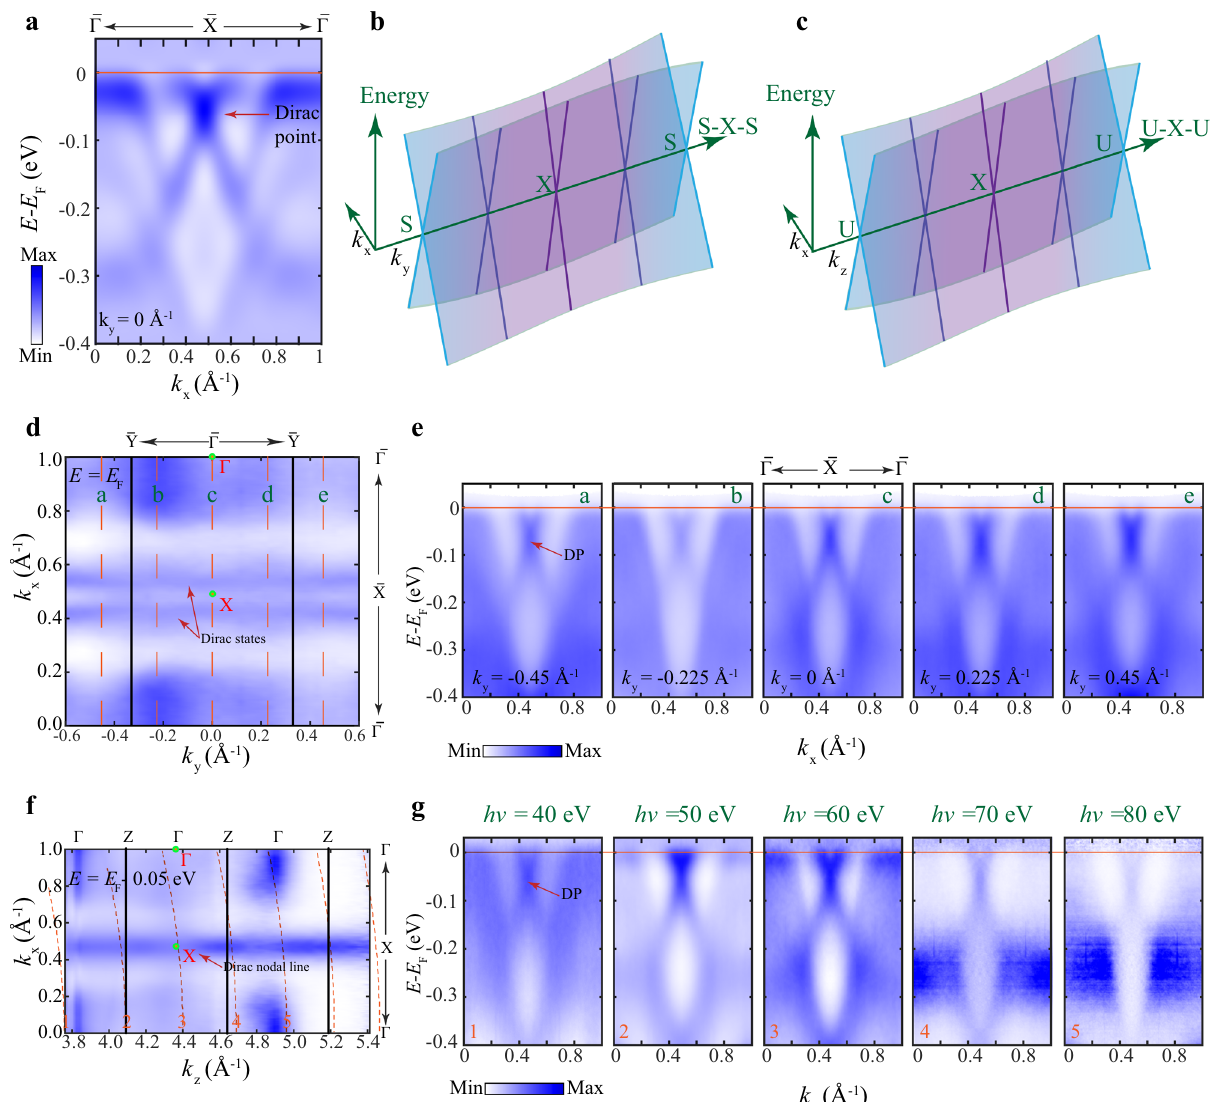
Fig. 2 Band structure of the 1D Dirac fermion of x = 0.43 ( n = 3) sample. a Second derivative of the photoemission spectrum d 2 A along d ω 2 Γ (cid:1) X (cid:1) Γ with DP labeled. b , c Schematic of the 1D Dirac fermion along the S-X-S ( k y ) and U-X-U ( k z ) directions. d The constant energy contour at Fermi energy ( E F ) in the k x – k y plane with Dirac surface sates labeled and theoretical BZ appended (black solid lines). e Sliced cut in Fig. 2d at different k y (orange dashed lines indicated in 2 d ) with DP labeled. f The energy contour near Fermi energy ( E F ) of the k x − k z plane with Dirac nodal line labeled. g Sliced cuts in Fig. 2f at different h ν ( k z - orange dashed lines) with DP labeled. To make a clear comparison, we symmetrized the dispersion according to the crystal symmetry. The data in Fig. 2a, d were collected at h ν = 55 Dirac cone dispersion along the k y direction could be found in Fig. 3e – j. As for x = 0.43 ( n = 3) sample, the Dirac velocity is 1.07 eV Å (~1.63 × 10 5 m s − 1 ) along Γ (cid:1) X (cid:1) Γ (Fig. 3f) and 0.98 eV Å (~1.49 × 10 5 m s − 1 ) at k y = − 0.30 Å − 1 (Fig. 3g); while for x = 0.40 ( n = 2) sample, the Dirac velocity is 1.44 eV Å (~2.19 × 10 5 m s − 1 ) along Γ (cid:1) X (cid:1) Γ (Fig. 3i) and 0.81 eV Å (~1.23 × 10 5 m s − 1 ) at k y = 0.30 Å − 1 (Fig. 3j). The rapid change of Dirac velocity is consistent with the schematic in Fig. 3c, d and suggests the 1D to 2D